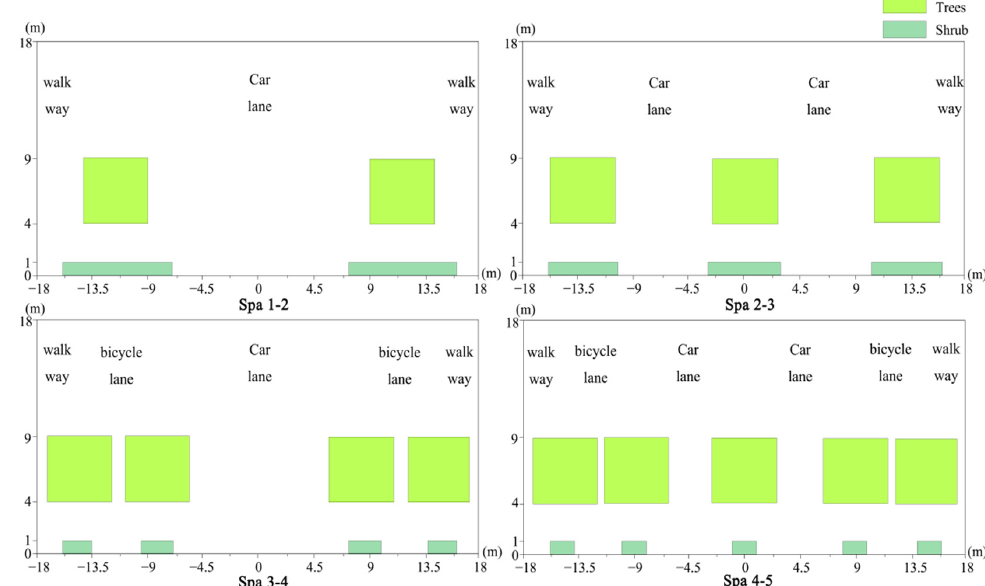
Figure 5. Schematic diagram of the road green belt scenarios.